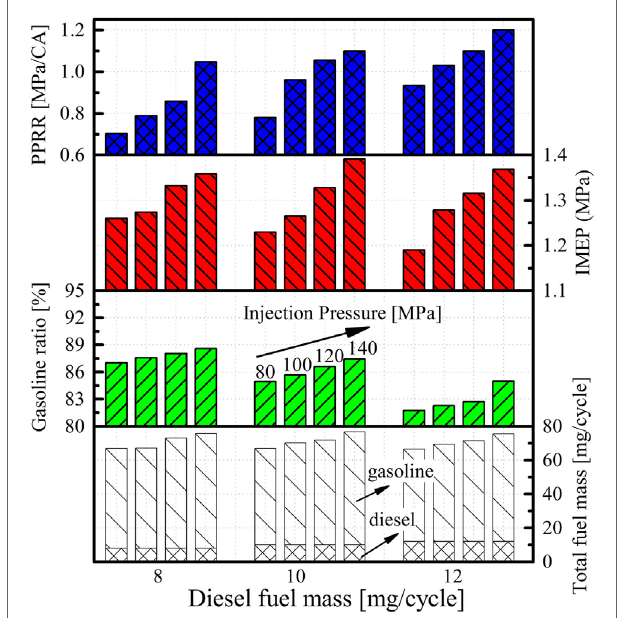
FiGURe 10 | effects of diesel injection pressure on the maximum achievable load in dual-fuel HPCC with dual-injection .